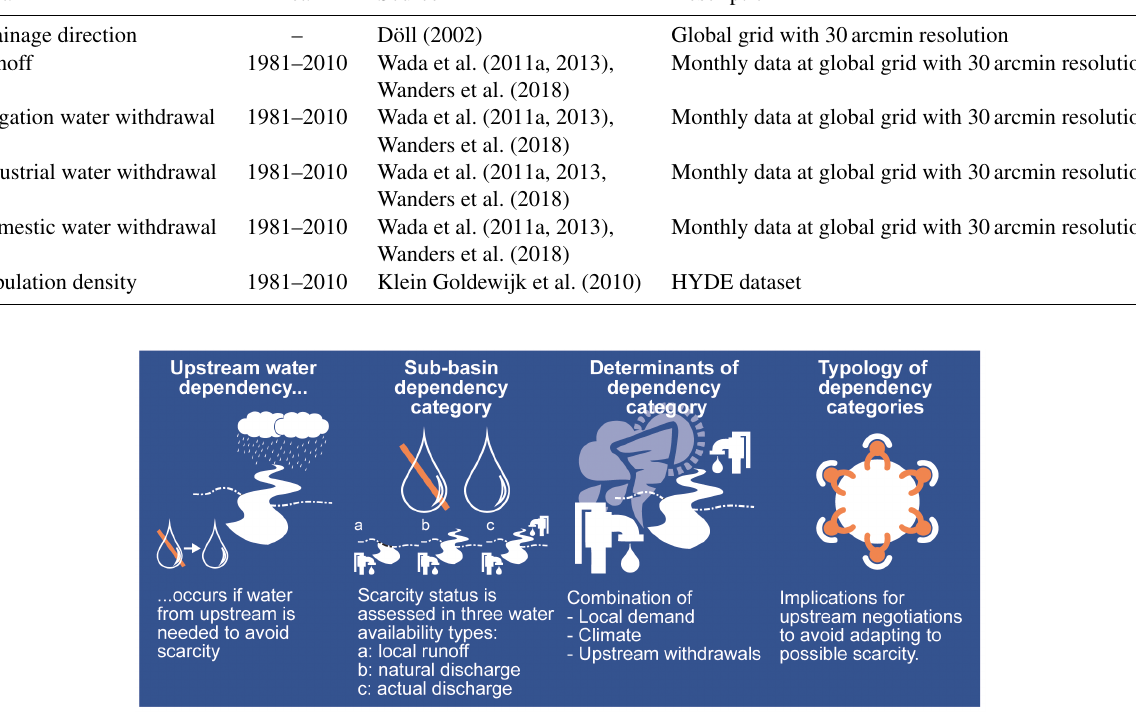
Figure 1. Key ideas of this study: our definition of dependency and themes addressed by our research questions.